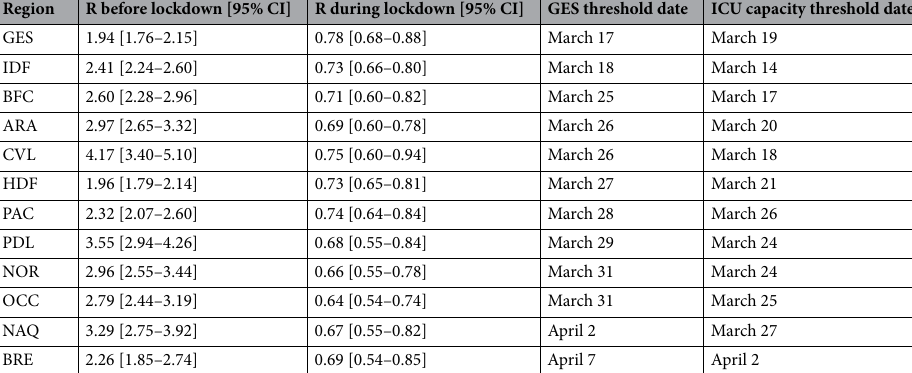
Table 1. Estimated values of R prelockdown and R lockdown and dates when GES threshold and ICU capacity threshold would have been reached. 95% CI: 95% confidence interval. GES threshold date: the date on which the estimated incidence of hospital admissions reached 6.50 per 100 000 inhabitants in the region. ICU capacity threshold date: the last date on which a lockdown would allow the region to stay below its ICU capacity limit. GES Grand-Est, IDF Ile-de-France, BFC Bourgogne-Franche-Comté, ARA Auvergne-Rhône- Alpes, CVL Centre-Val de Loire, HDF Hauts de France, PAC Provence-Alpes-Côte d’Azur, PDL Pays de la Loire, NOR Normandie, OCC Occitanie, NAQ Nouvelle-Aquitaine, BRE